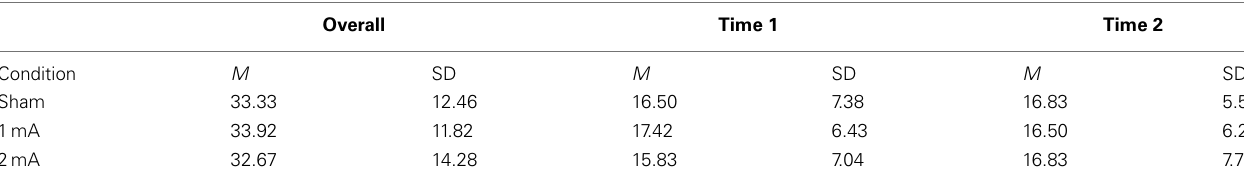
Table 2 | Mean and SD for accuracy of 3-back by current and time.